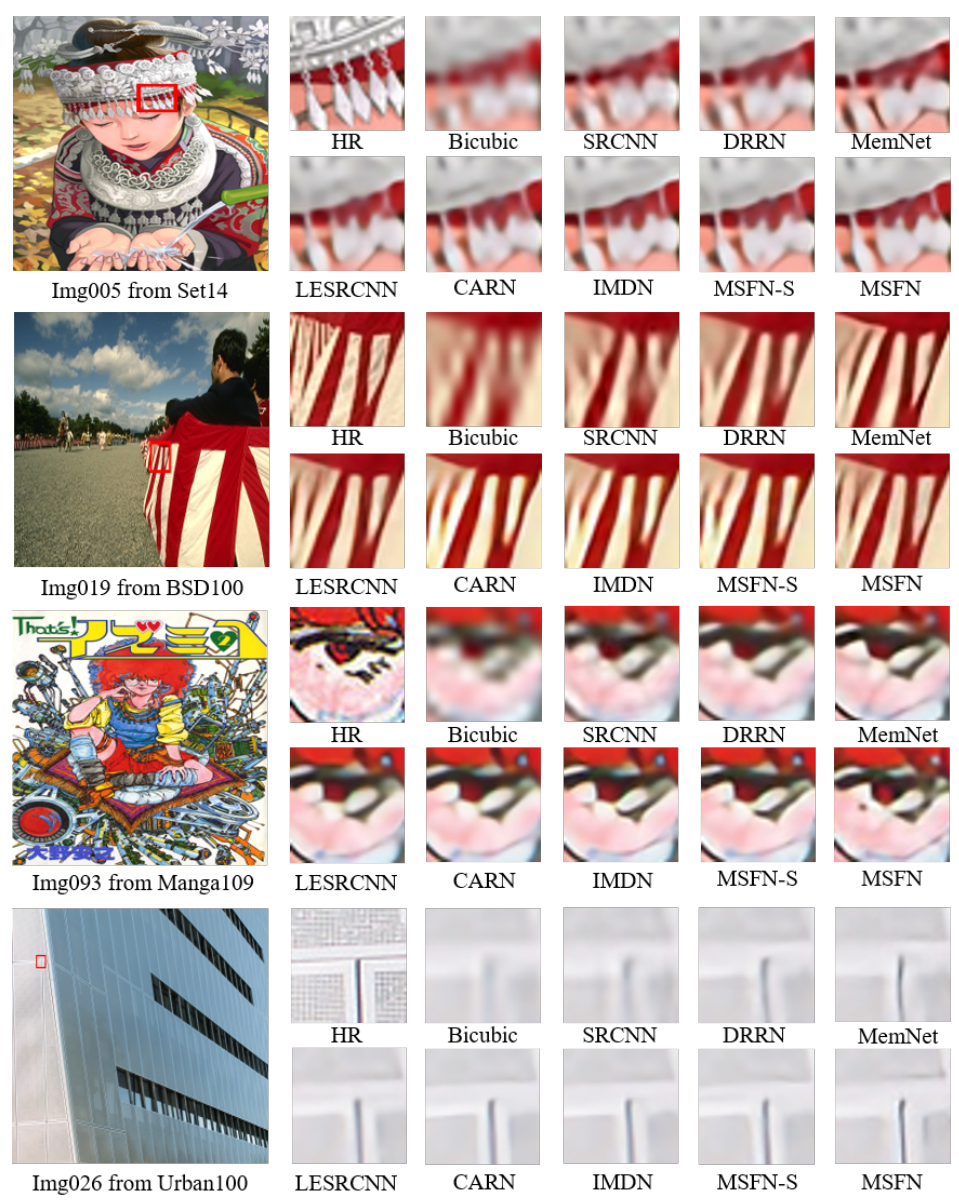
Figure 9. Comparison of reconstructed HR images of img005, img019, img026, and img093 by different SR algorithms with the scale factor ×